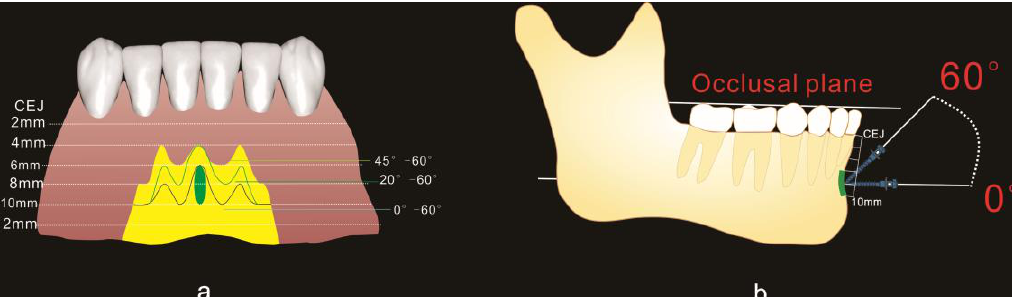
Figure 8 . Recommended sites with appropriate insertion angles for mini implants at the mandibular symphysis region. ( a ) Frontal view. The yellow areas are feasible for mini-implant placement where OBT is greater than 5 mm and CBT is 1 – 2 mm. Different insertion angles are recommended for different subregions. The recommended insertion angle is 45 – 60 degrees for the yellow areas occlusal to the green line, 20 – 60 degrees for the yellow areas between the green and black line, and 0 – 60 degrees for the yellow areas apical to the black line. The oval green area is optimal for mini-implant placement, where OBT and CBT were the thickest, with an insertion height of less than 10 mm for the prevention of soft tissue irritation. ( b ) Lateral view of the optimal site and virtually placed mini implants in the optional range of insertion angles.